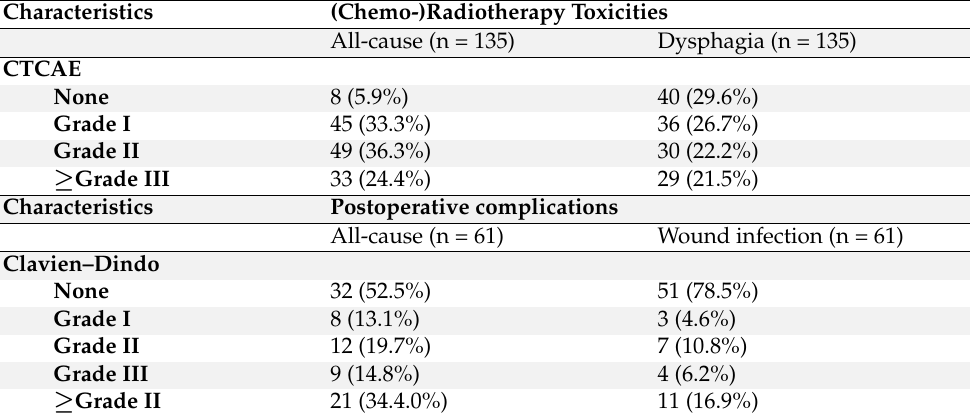
Abbreviations: CTCAE = Common Terminology Criteria for Adverse Events.